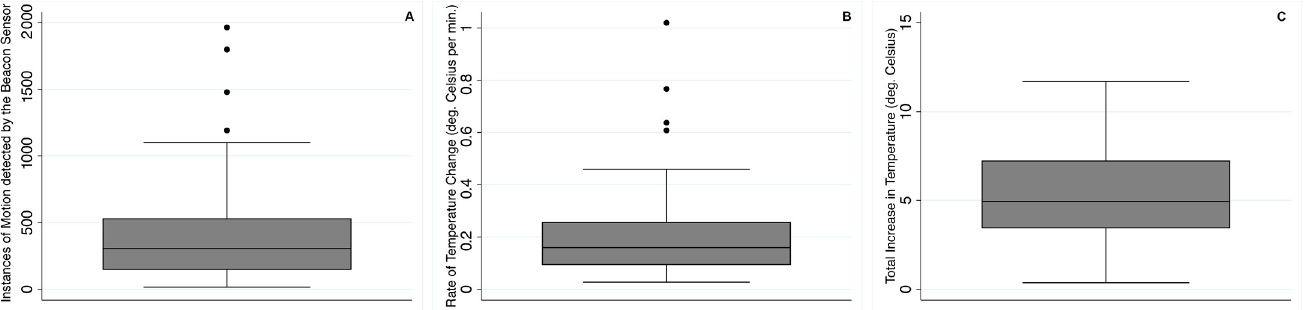
Figure 2. Box plots to show the distribution of the beacon sensor data across all subjects for: ( A ) the number of instances of motion per magnifier use, ( B ) rate of temperature change and ( C ) total temperature rise during each magnifier use. In the box plots, the bottom and top of the box are the 25th and 75th percentile (i.e., the upper and lower quartiles, respectively), and the band near the middle of the box is the 50th percentile (i.e., the median). The ends of the whiskers represent the lowest datum within 1.5 times the interquartile range of the lower quartile and the highest datum still within 1.5 times the interquartile range of the upper quartile. Outlier data are represented by individual dots.